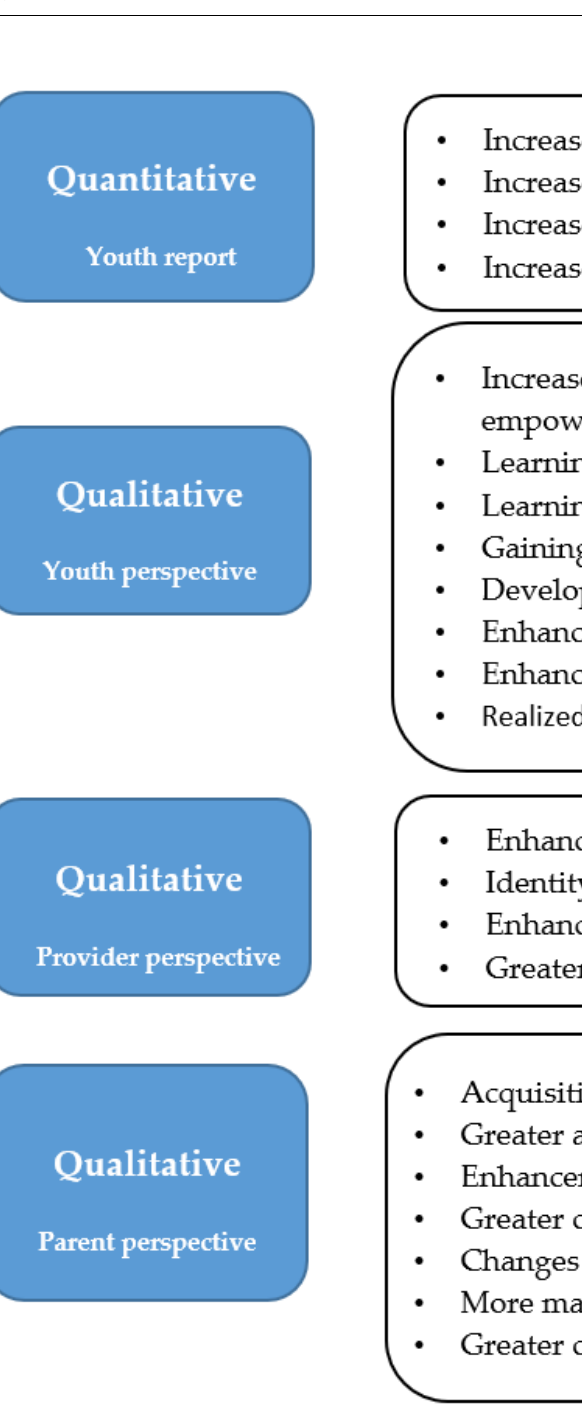
Figure 3. Evidence for Youth Outcomes from RILS Programs. This figure refers to findings from several articles [1,33,34,36–39,50]. several articles